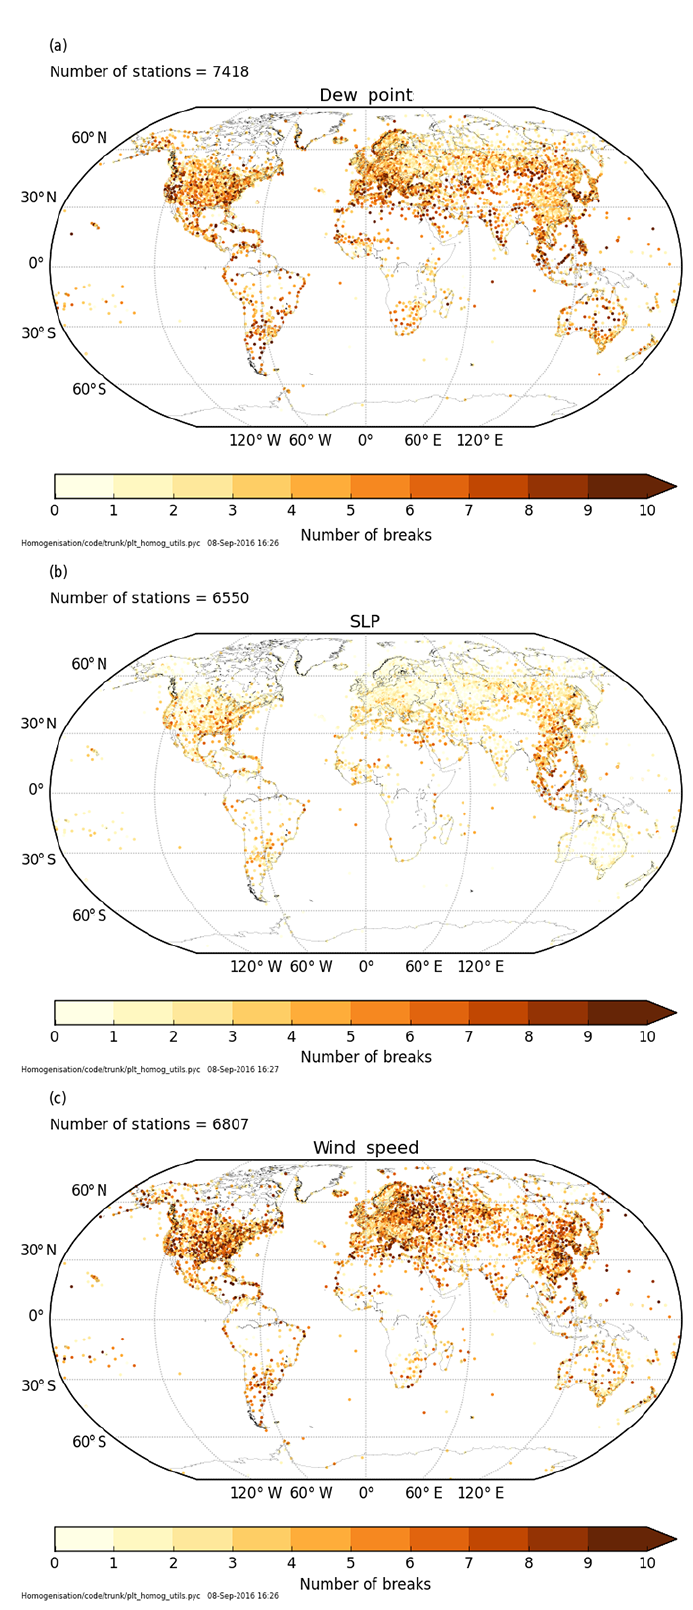
Figure A2. The number of change points detected for each station for dew point, SLP and wind speed.